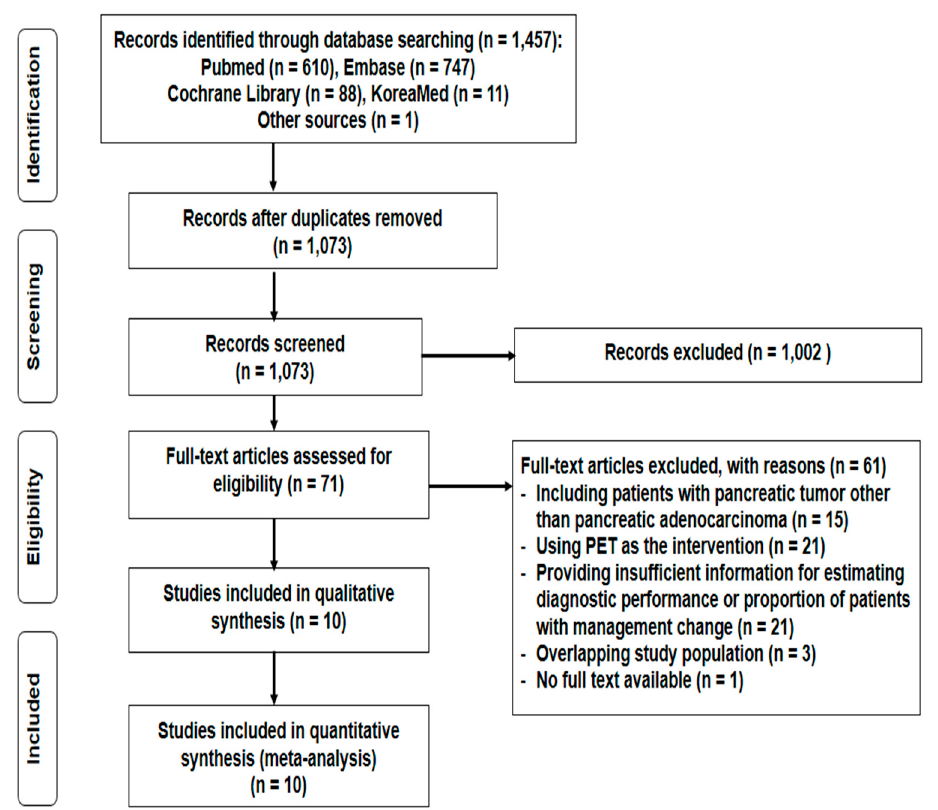
Figure 1. PRISMA flow diagram showing the process of study selection.